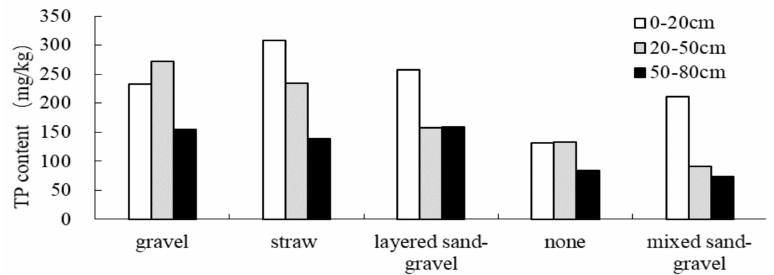
Figure 4. Total phosphorus (TP) content of the soil before